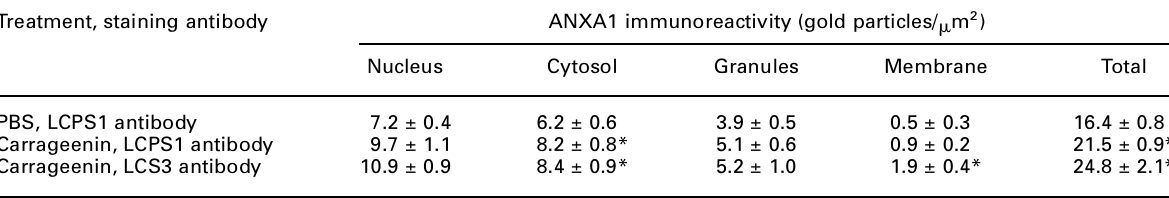
Table 1. Distribution of ANXA1 immunoreactivity in rat eosinophils in basal and inflammatory conditions Treatment, staining